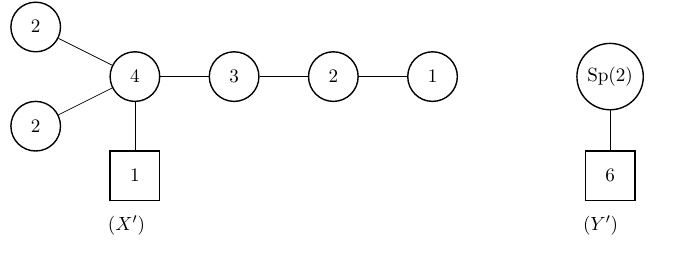
Figure 36 . Sp(2) gauge theory with N f = 6 flavors and its mirror dual.